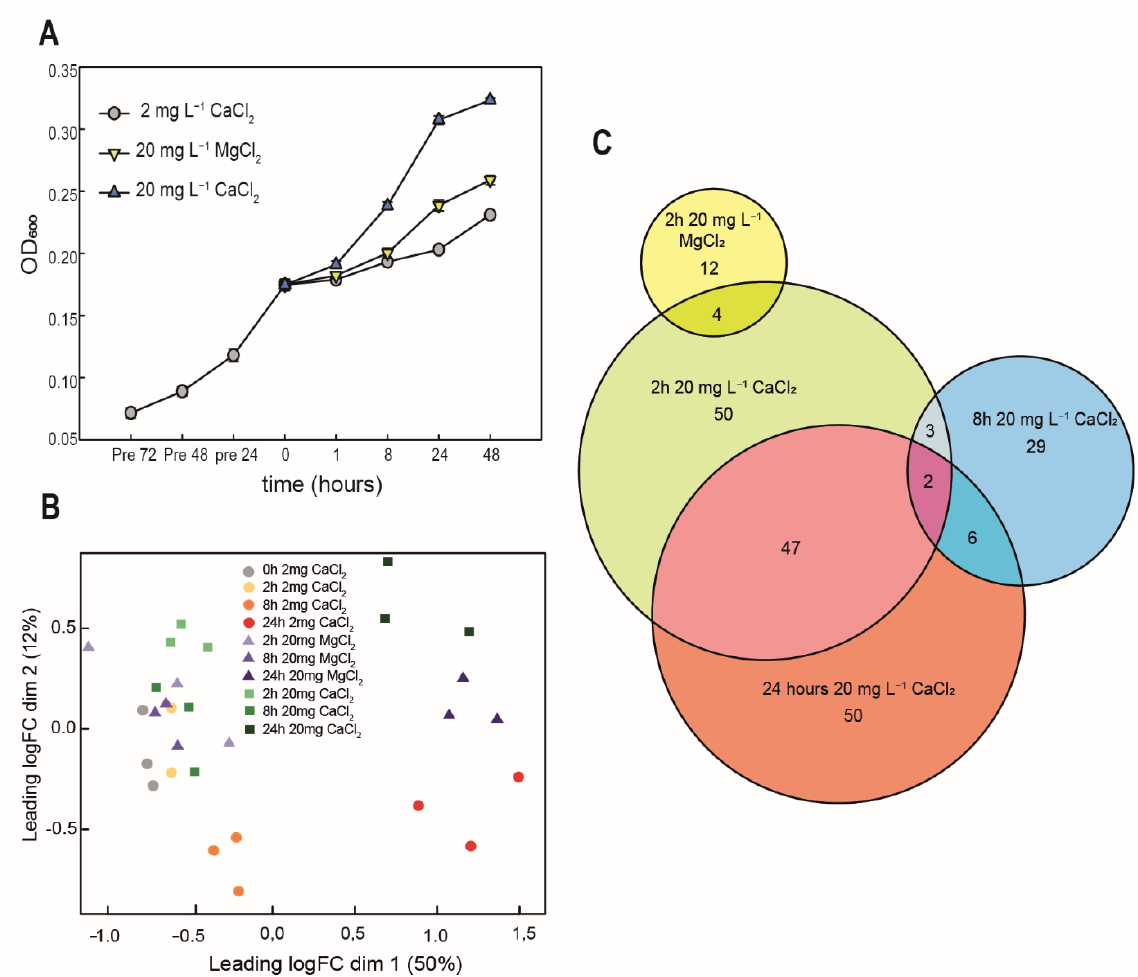
Figure 6. ( A ) The figure shows the growth rate of G. phototrophica grown in 20 mg CaCl 2 L −1 and no growth in 2 mg CaCl 2 L −1 (Note: scale bar in the x -axis is uneven). ( B ) Multi-Dimensional Scaling (MDS) plot showing the similarity between the treatment replicates. ( C ) Venn diagram showing the differentially expressed genes in 20 mg MgCl 2 L −1 and 20 mg CaCl 2 L −1 at 2 h, 8 h and 24 h after the amendment.